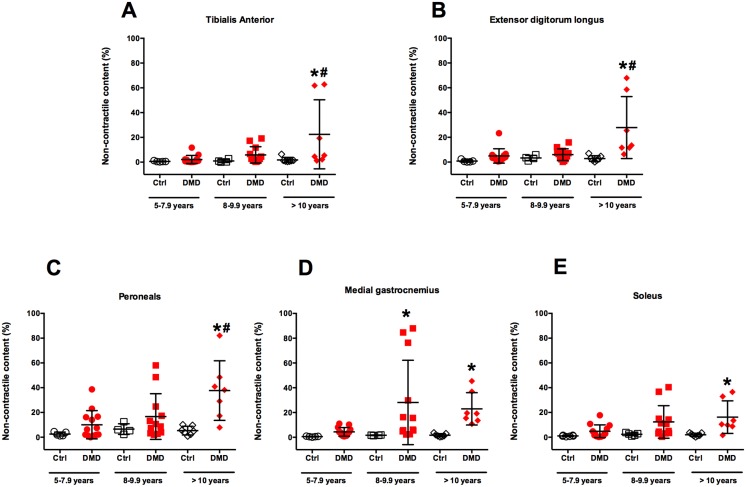
Percent non-contractile content (NCC) in leg muscles of Ctrl and DMD in different age groups.NCC of leg muscles of DMD at the age of >10 years was significantly different from 5–7.9 and 8–9.9 years age groups (denoted by #, p<0.05). NCC of TA, EDL, Per, MG, and SOL of DMD were significantly different than Ctrl in > 10 year age group (denoted by *, p<0.05). Additionally, only MG showed significant differences between DMD and Ctrl group at the age of 8–9.9 year. Data is presented as mean (SD).